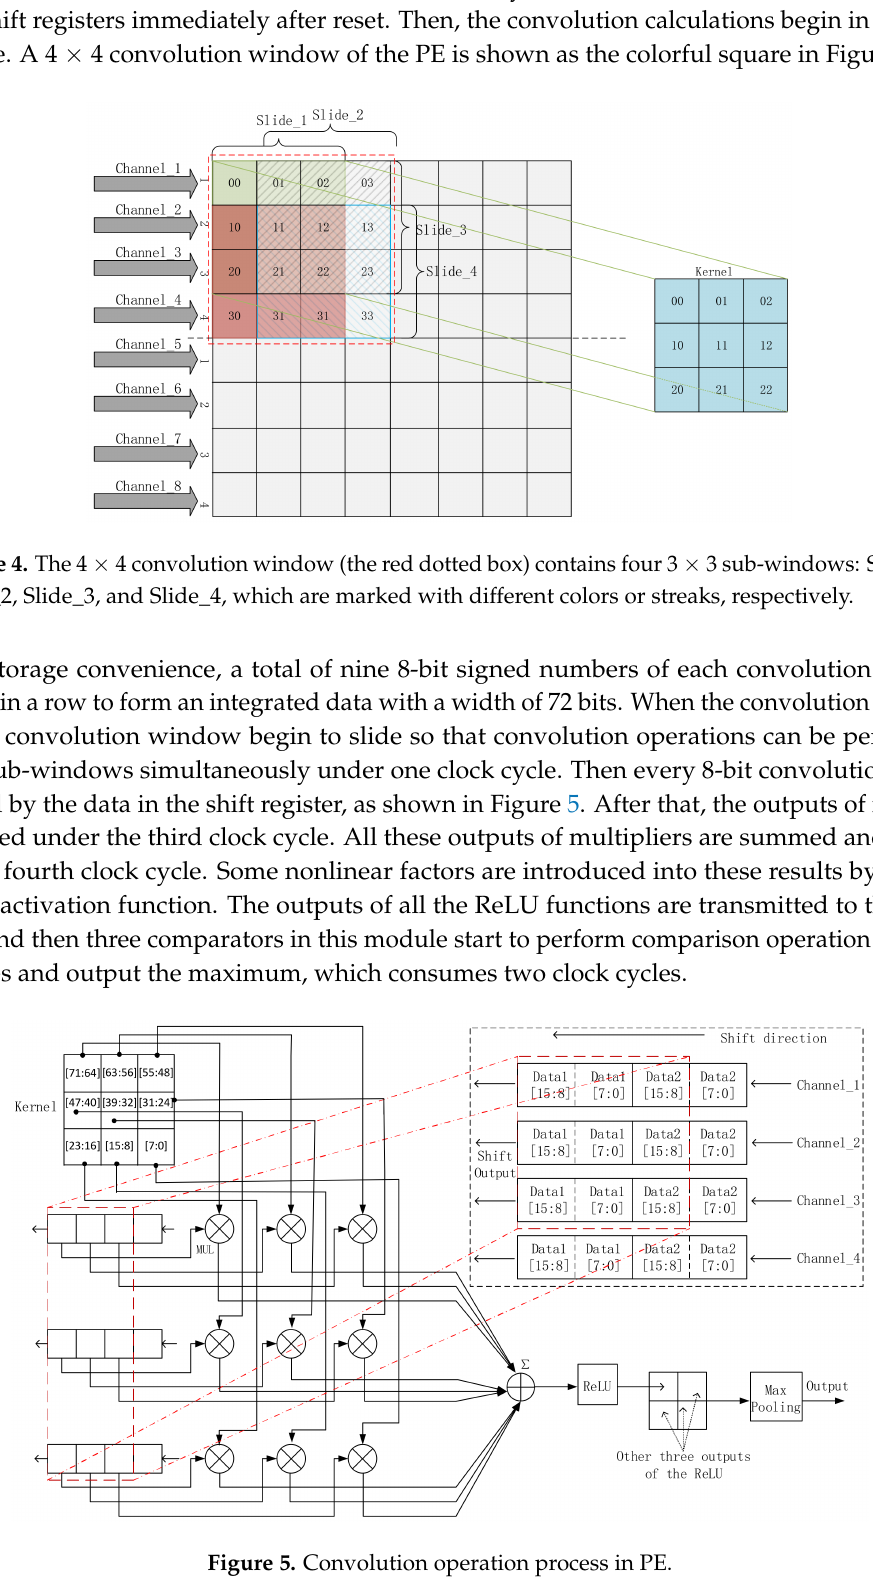
Figure 5. Convolution operation process in